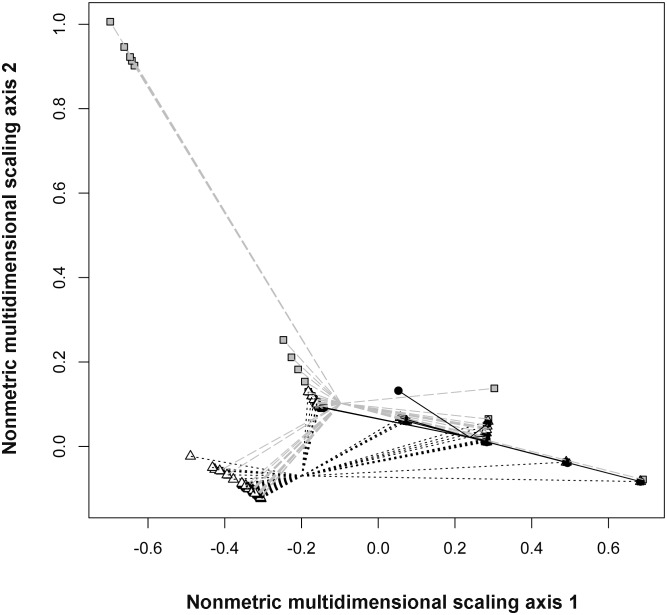
Ordination plot of microhabitat used by the three anurans in NT and WA.The plot shows the first two axes of a Nonmetric Multidimensional Scale analysis for microhabitat use of Rhinella marina (black circles), Litoria caerulea (triangles) and L. splendida (squares). Solid black lines connect all microhabitats used by R. marina with the centroid of all observations for the species. Hatched grey lines and hatched black lines connect microhabitats used by L. caerulea and by L. splendida, with the respective centroids for each species.